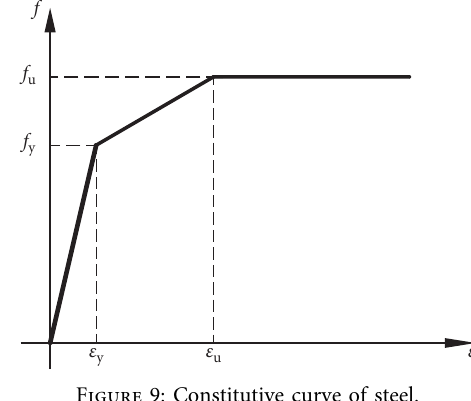
Figure 9: Constitutive curve of